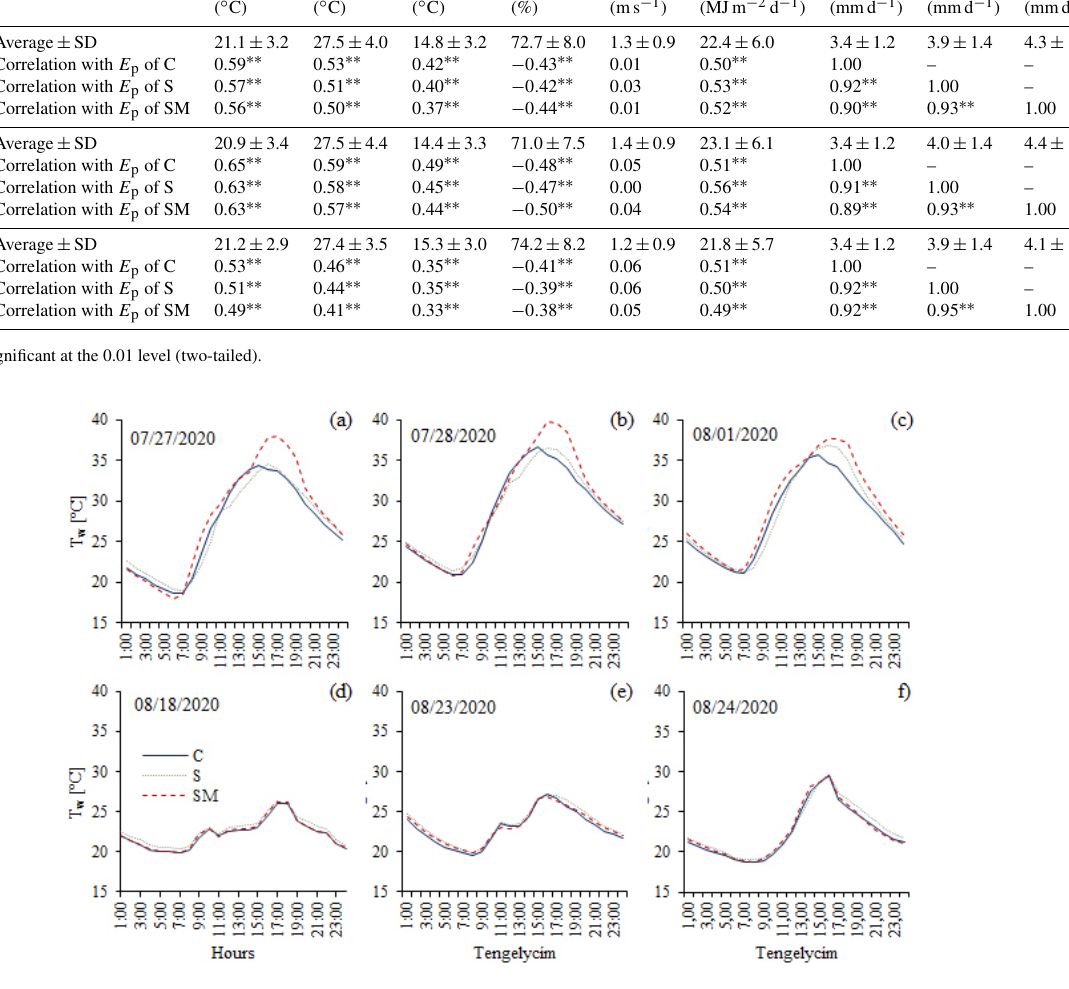
Figure 5. Water temperature of different pan treatments (C – class A pan/control; S – class A pan with sediment covered bottom; SM – class A pan with submerged macrophyte) in clear-sky and cloudy sample days. The layers represent the distance from the pan bottom. The lowest sensors’ height was